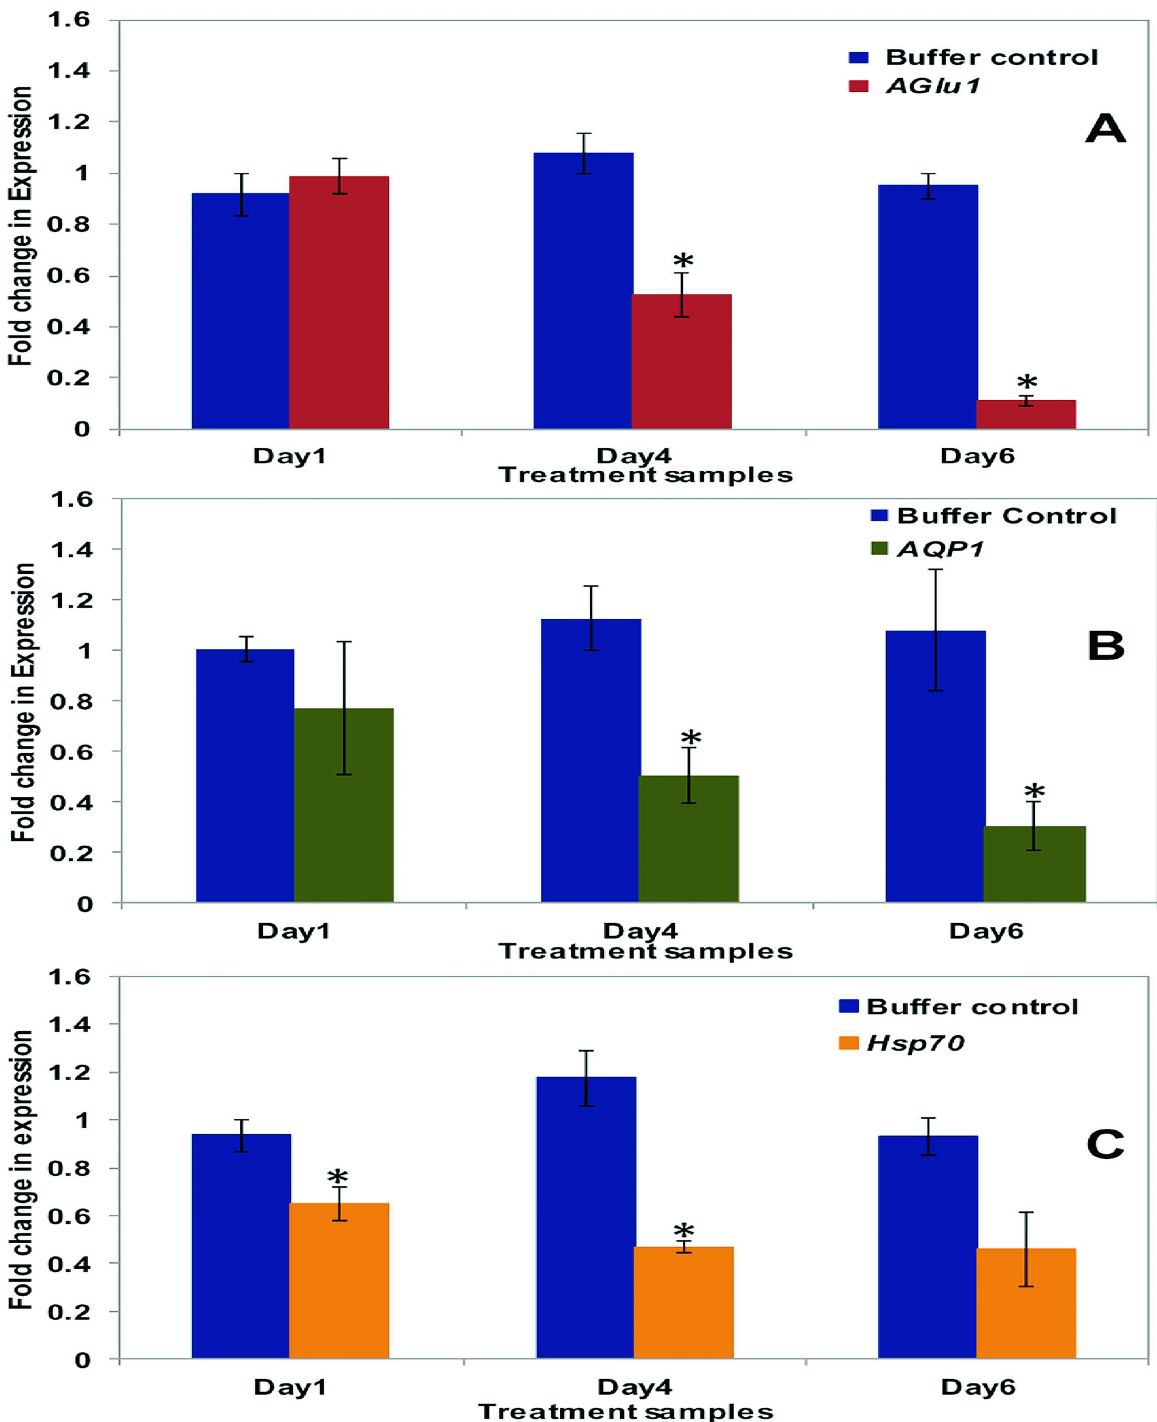
Fig 2. Results of qPCR analysis of gene targets involved in osmoregulation and thermo tolerance. Real-timeqPCR amplification of expressedwhitefly genes involvedin osmoregulation, post-RNAi knock down. (A) Comparison of fold-changesin expression of Alpha glucosidase1 ( AGLU1 )for whitefly treated with 30 μ g/ml of AGLU1 dsRNA (red) and buffer control (blue) at day one, four, and six, post-treatment (x-axis). (B) Comparison of fold-changesin expressionof Aquaporin1 ( AQP1 ) for whitefliestreated with 30 μ g/mlof AQP1 dsRNA (green), and the buffer treated control (blue) at day one, four and six, post-treatment (x-axis). (C) Comparison of fold-changes in expressionof Heat shock protein 70 ( Hsp70 )for whitefliestreated with 30 μ g/mlof Hsp70